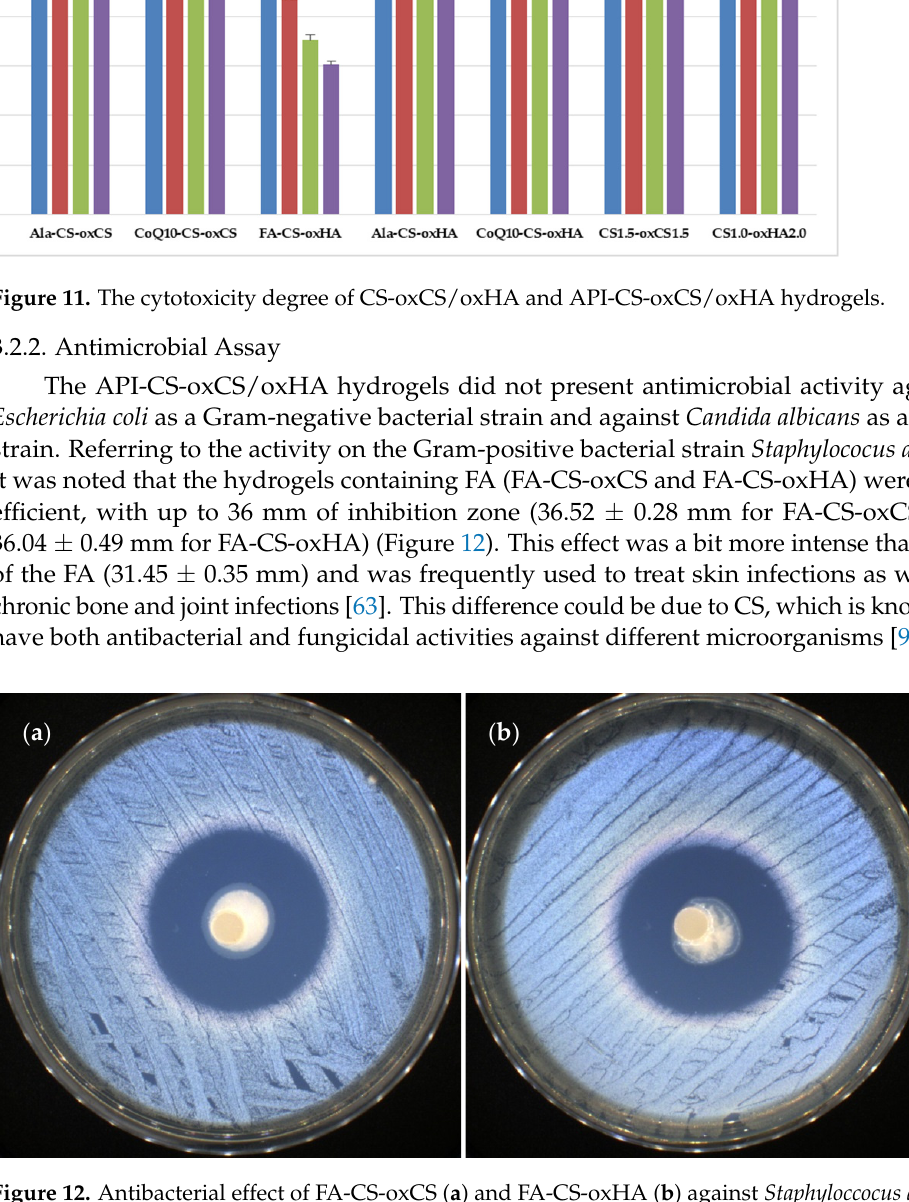
Figure 12. Antibacterial effect of FA-CS-oxCS ( a ) and FA-CS-oxHA ( b ) against Staphyloccocus aureus .